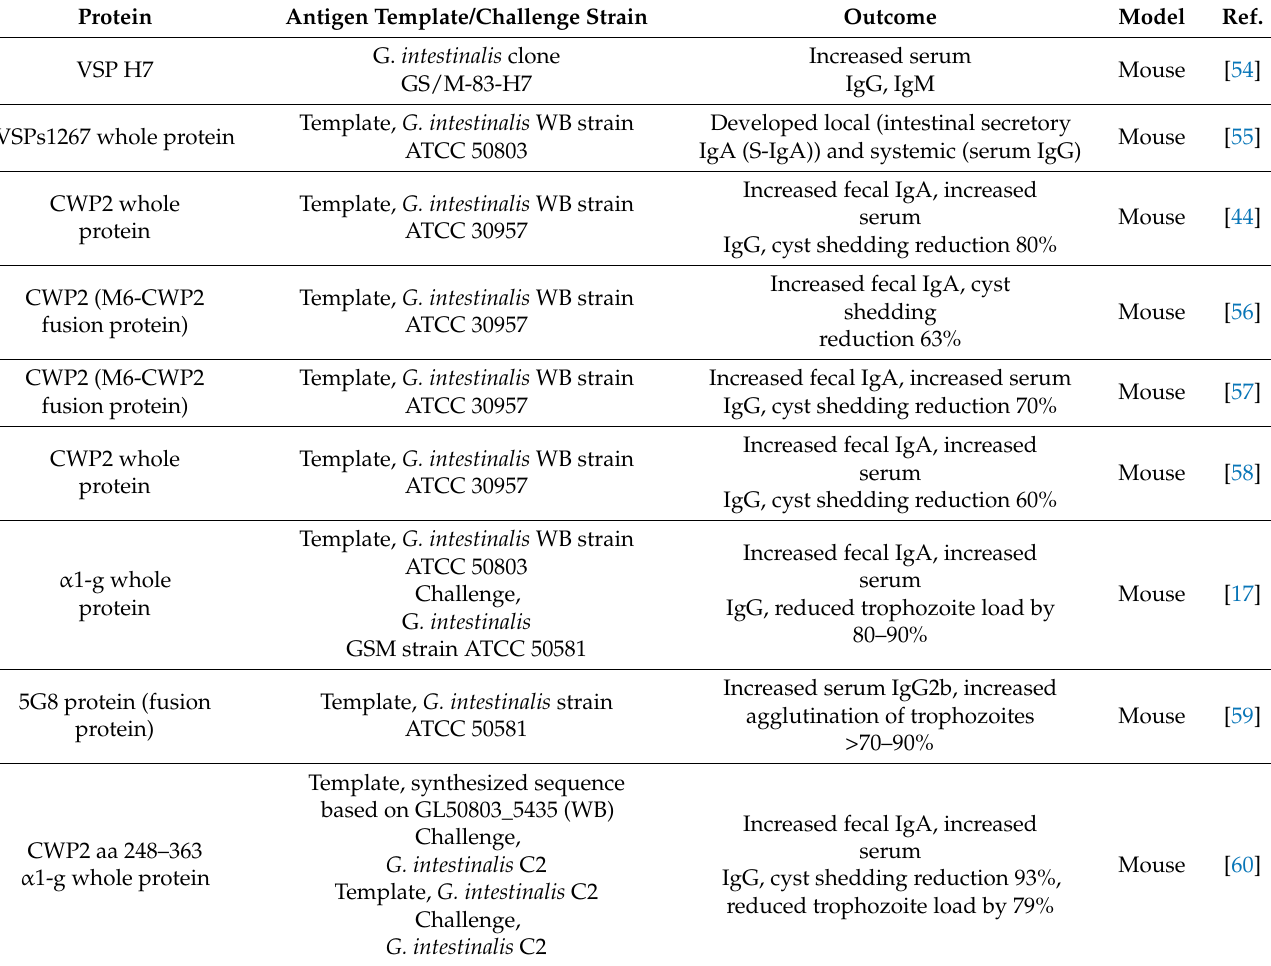
Table 1. Antigenic protein candidate vaccines and challenge studies performed in mouse